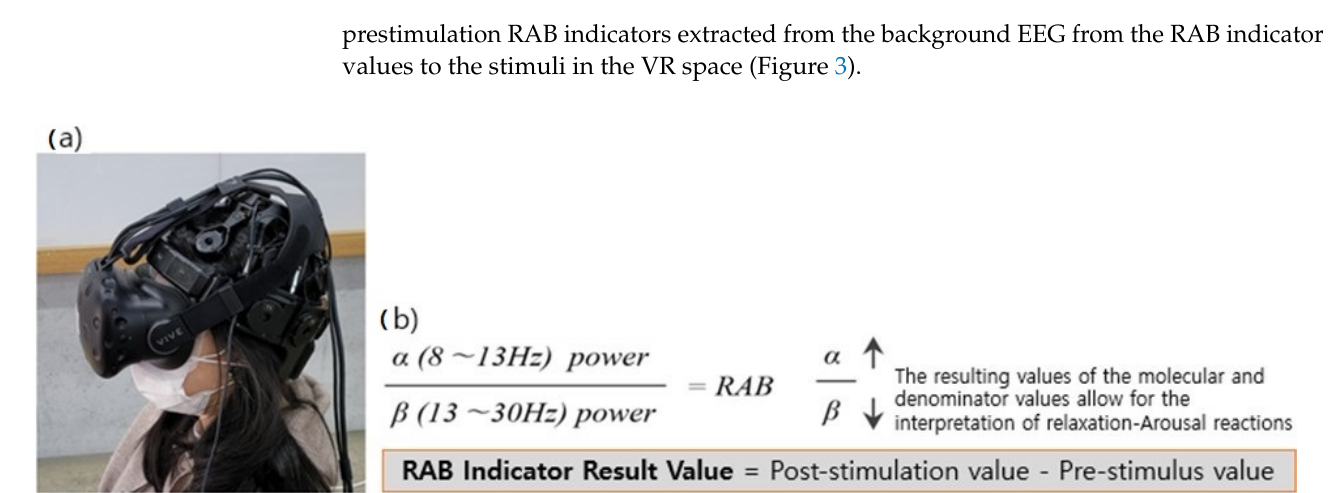
(b) Figure 2. VR space 360° 3D image example. ( a ) It is an image with 2.3 m of ceiling height and 80% of window area ratio applied to the aspect ratio A type of space. ( b ) It is an image with 2.3 m of ceiling height and 60% of window area ratio applied to the aspect ratio of the space B type. 3.4. Tools Used in the Experiment and EEG Data Analysis Indicators We used SMI’s Eye Tracking HMD based on HTC Vive as the VR device,